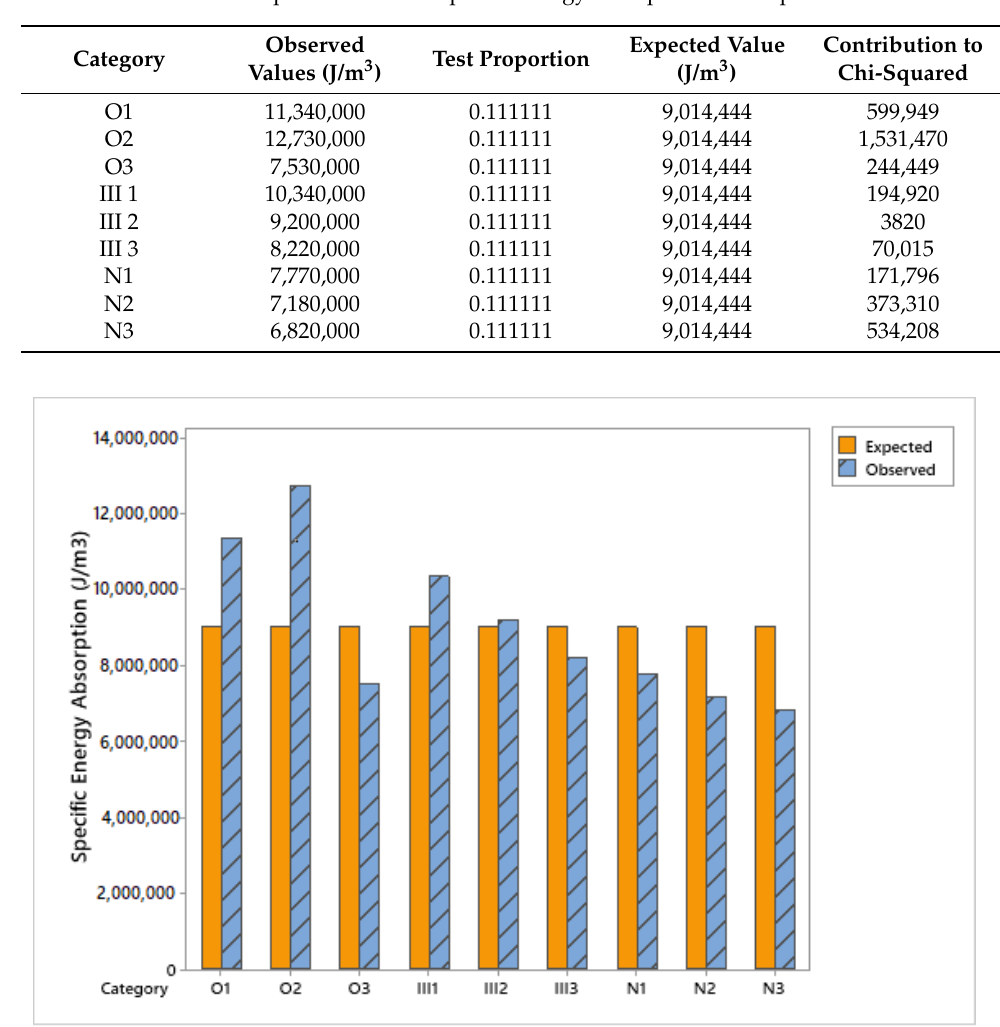
Figure 12. Observed vs. expected specific energy absorption values.